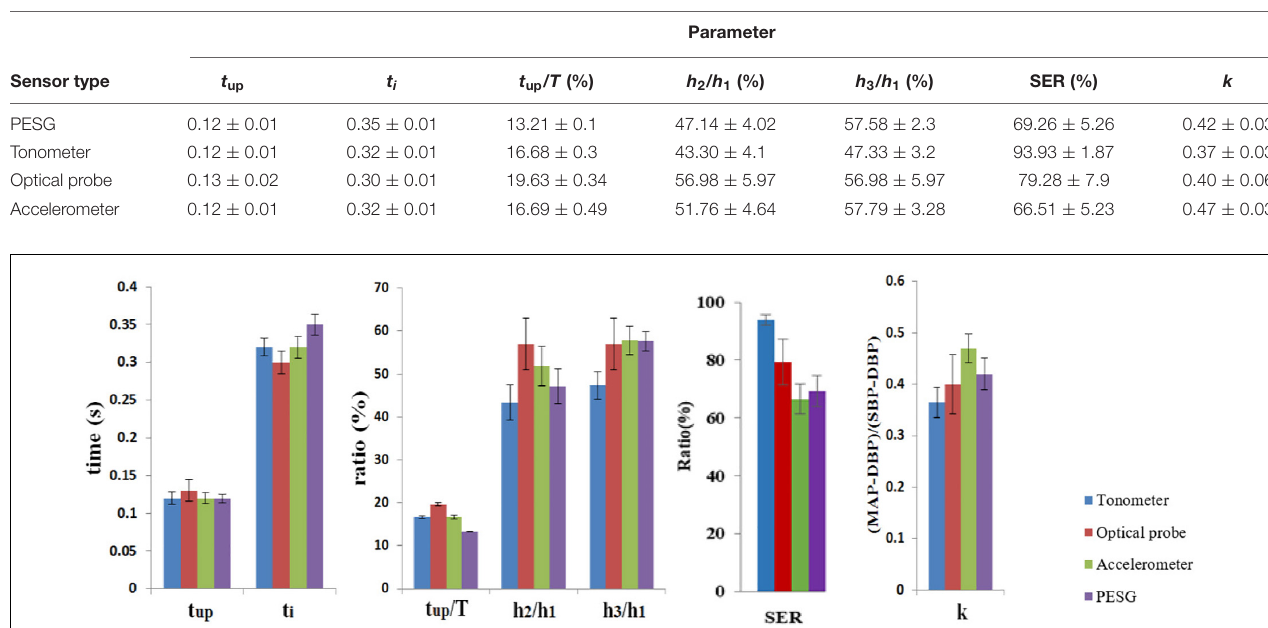
TABLE 8 | Comparison of the mean ± SD of the parameters obtained by all four sensors for all subjects.